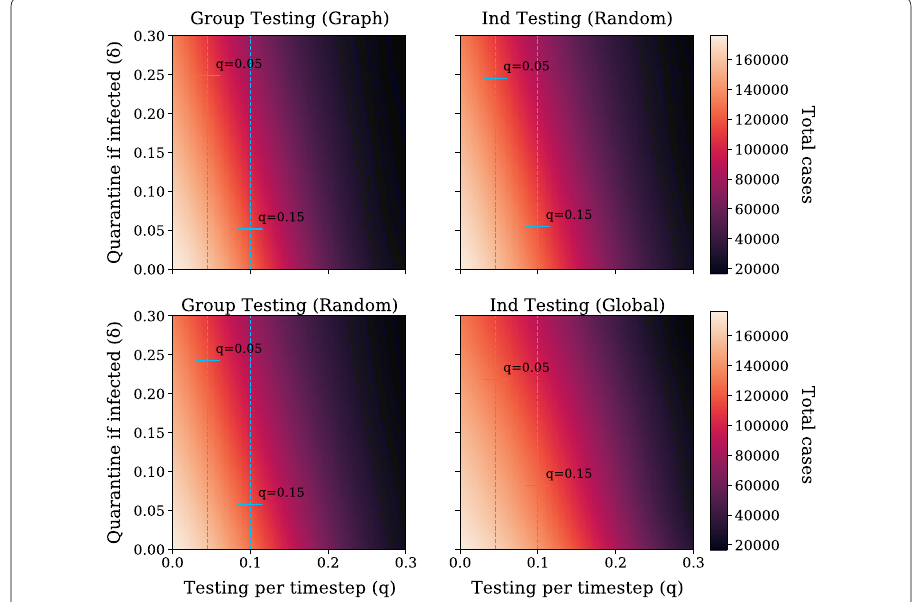
Fig. 8 Each figure illustrates the effect of voluntary quarantining ( δ ) and the degree of testing ( q ) on total COVID cases, averaged across ten trials. For both axes, the experiments are conducted at intervals of 0.05 from 0 to 0.3. Gaussian process regression is used for interpolation. The vertical lines show testing at two different levels, and the horizontal lines show where the two levels of testing result in similar case